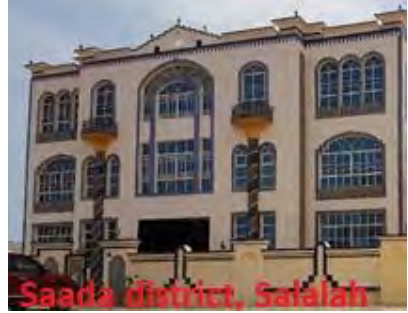
Figure 13. Fac¸ade’s photograph building location